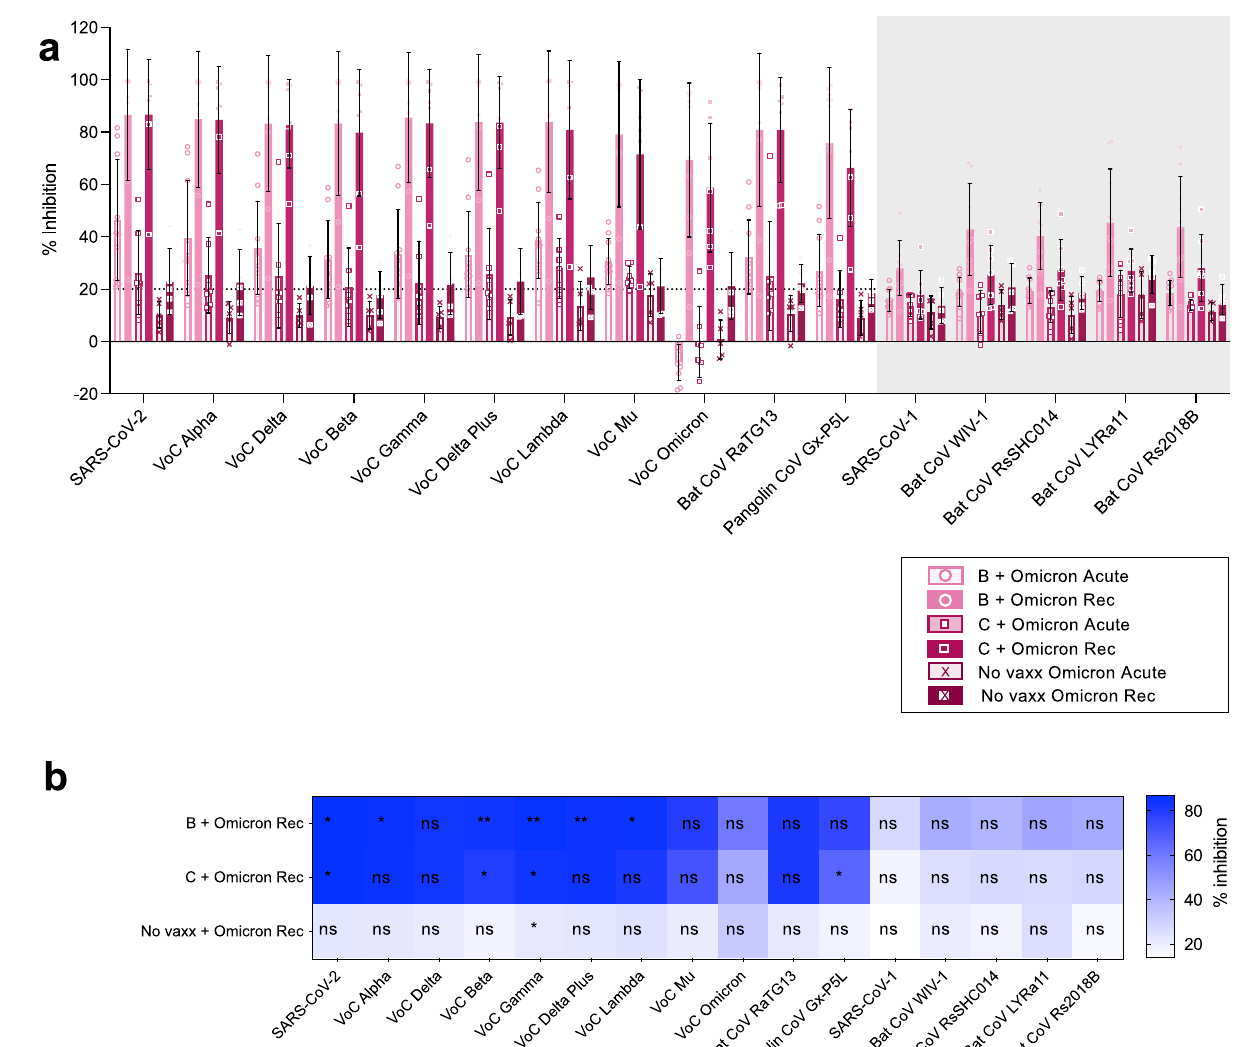
Fig. 4 | Omicron infection in combination with vaccine priming broadens antibody response. The % antibody inhibition of ACE2 binding to RBD was determined for a BNT162b2 (n=10 subjects), Coronavac ( n =7 subjects), unvacci- nated ( n =5 subjects) paired acute (day 0 – 5) and recovered (1 – 2 months after illness)patientsforOmicronBA.2infection. a Datarepresentedmean+/ − stdevand